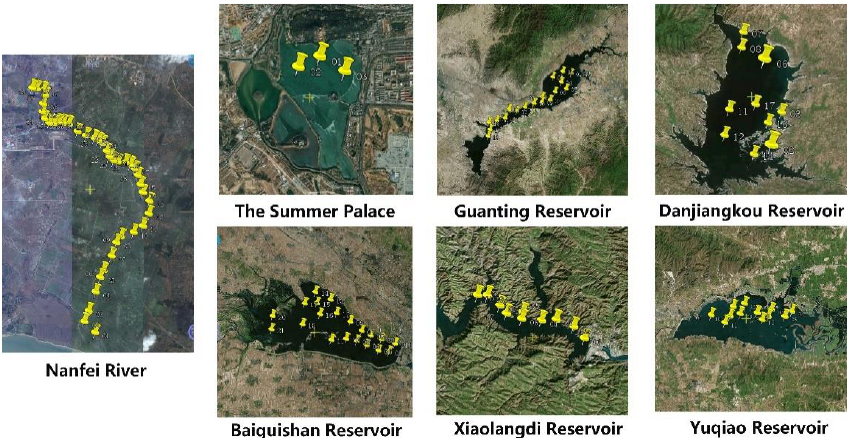
Figure 1. Distribution maps of sampling points in smartphone water quality monitoring experiment, based on automatic exposure. Table 1. Overview of the water quality monitoring experiment, based on automatic exposure of smartphones.